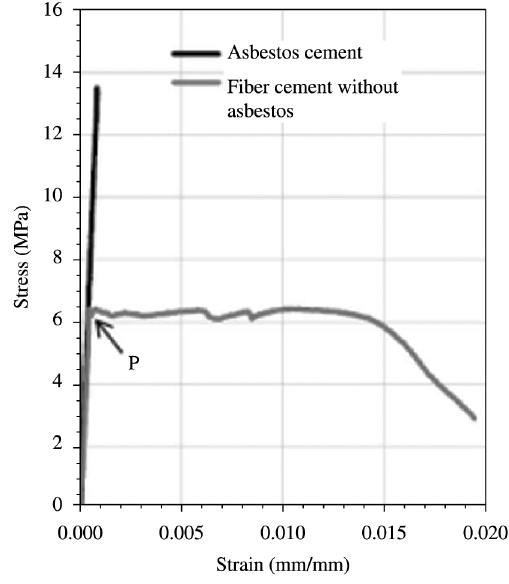
Figure 12. Curves of stress versus strain obtained from tension tests in specimens extracted of sheets available in Brazil 3